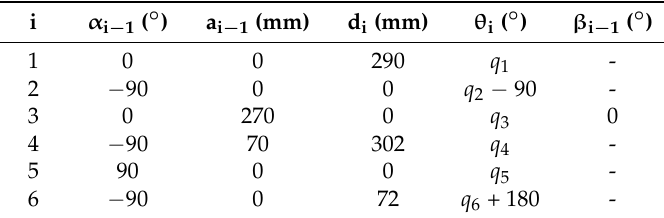
Figure 5. Reference frames associated with the robot arm. Table 3. ABB IRB120 nominal parameters.